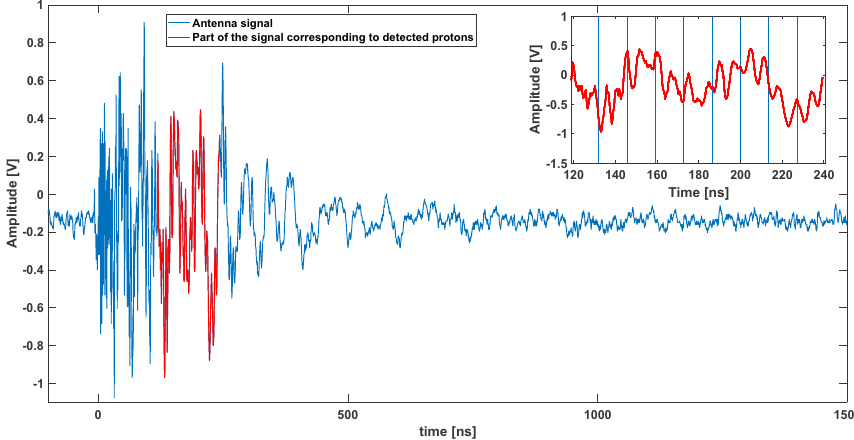
Figure 4. Detected EMP signal (blue curve). Its part highlighted with red corresponds to the TOF derived from the parabolic track of protons in Figure 3 from 120 to 243 ns; (inset) 9 samples into which the signal corresponding to TOF was